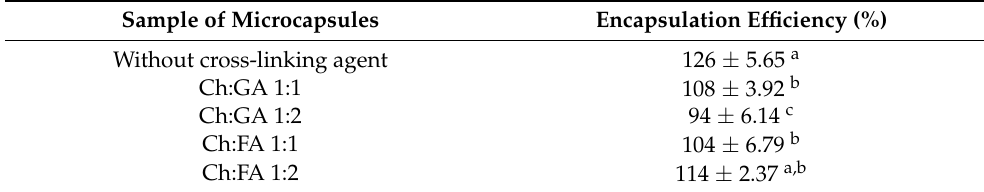
Table 2. The moisture content in samples of the chitosan/sodium dodecyl sulfate (Ch/SDS) micro- capsules. Different superscript letters (within one column) represent significant differences ( p < 0.05), as obtained by ANOVA and Tukey’s HSD